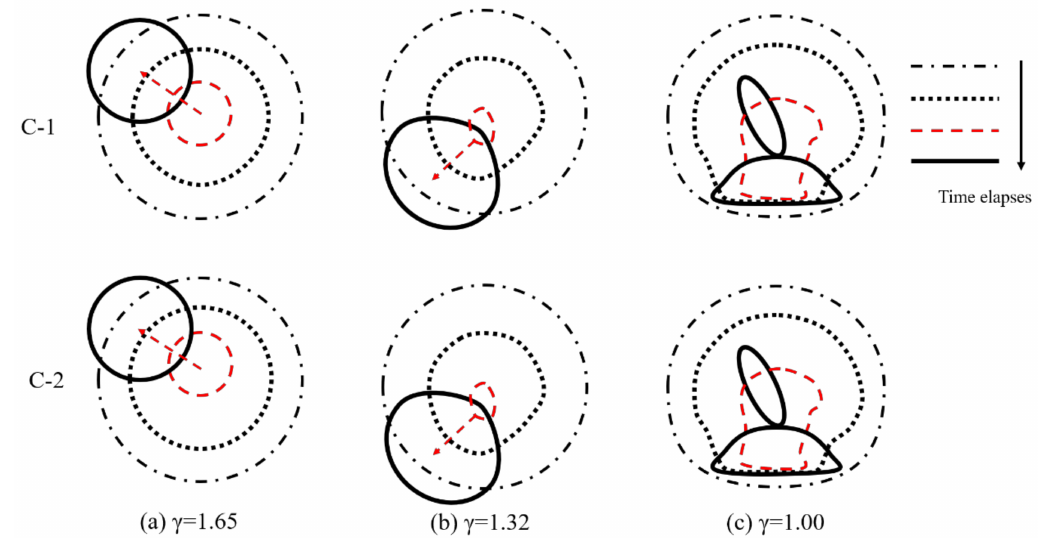
Figure 5. Comparison of bubble collapse patterns in front view near C-1 and C-2 plates under different initial distances